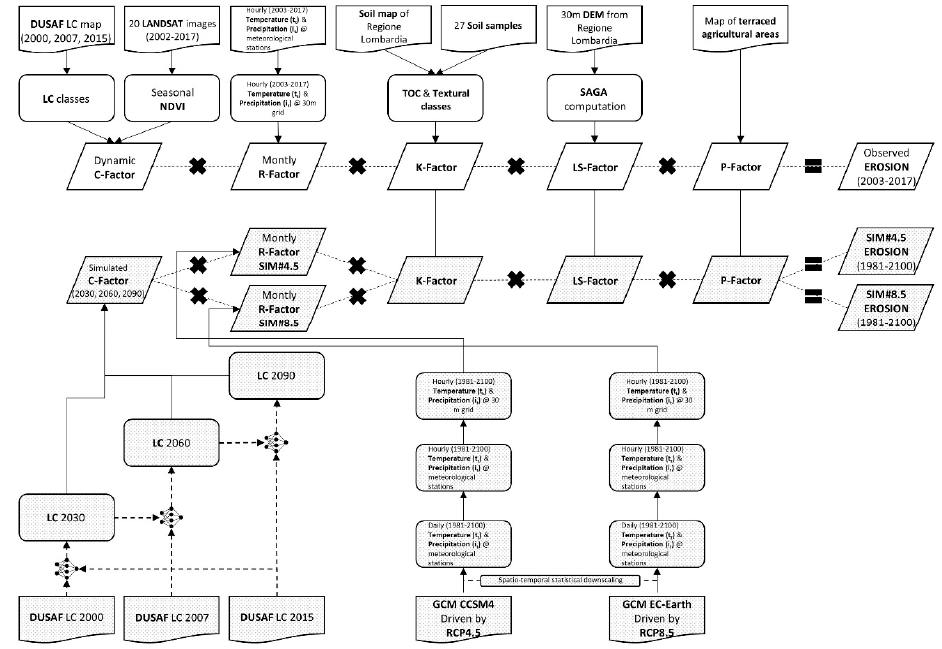
Figure 2. Experimental framework.